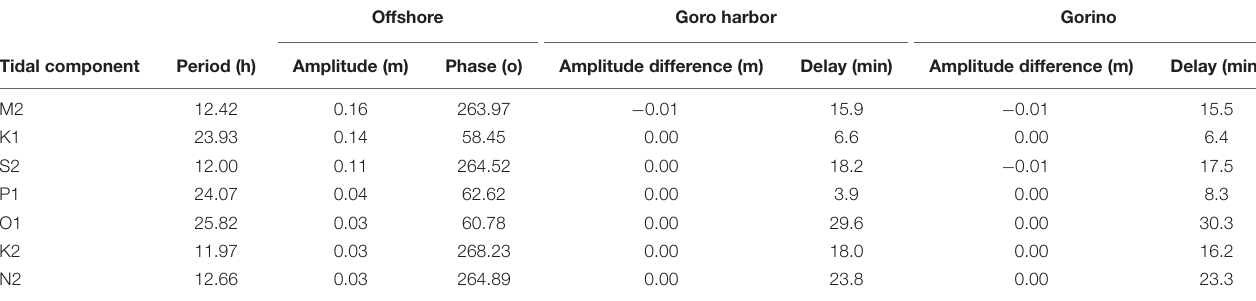
FIGURE 4 | Average surface (A) and bottom (B) circulation, and (C) current speed along the inlet vertical cross section, indicated with the black line. Green colors indicate saltier water entering the lagoon, and blue colors indicate fresher water exiting the lagoon. Despite how it looks like in the panel (C) , the western channel (“Bocca principale”) is deeper and wider with respect to the eastern channel (“Bocca secondaria”). Only few grid points of the western channel near the tip of the sand spit, are deeper than the western channel ( Figure 1 ). TABLE 2 | Characteristics of the offshore tidal signal and its modification inside the lagoon. Offshore Goro harbor